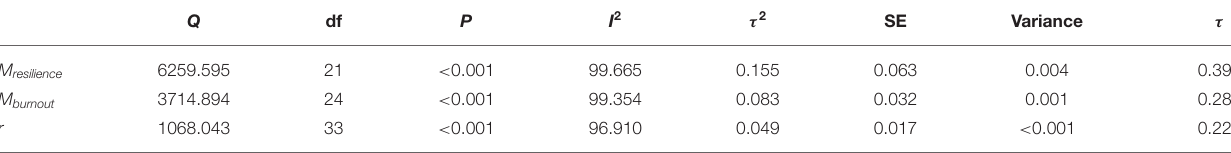
TABLE 2 | Heterogeneity analysis.